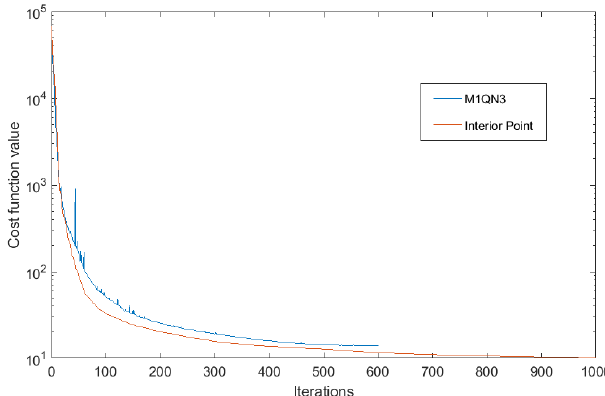
Figure B1. A comparison of the performance of the interior-point algorithm in MATLAB used by default in Úa and the M1QN3 op- timisation scheme used by ISSM and STREAMICE, showing min- imisation of the cost function during the inversion